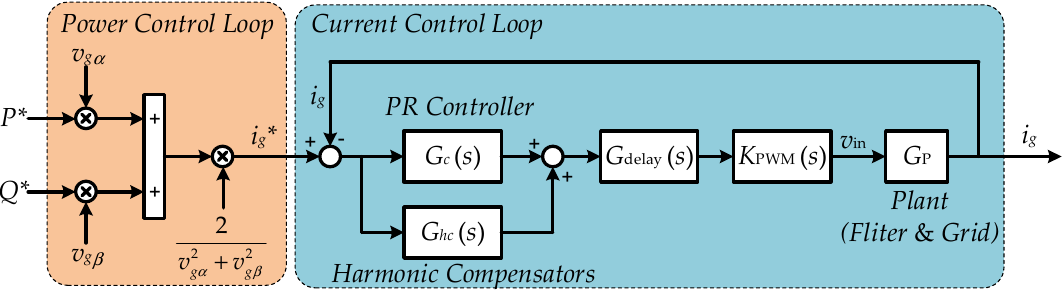
Figure 10. Control diagram of the single-phase PV system based on the single-phase instantaneous active and reactive powers (PQ) theory.